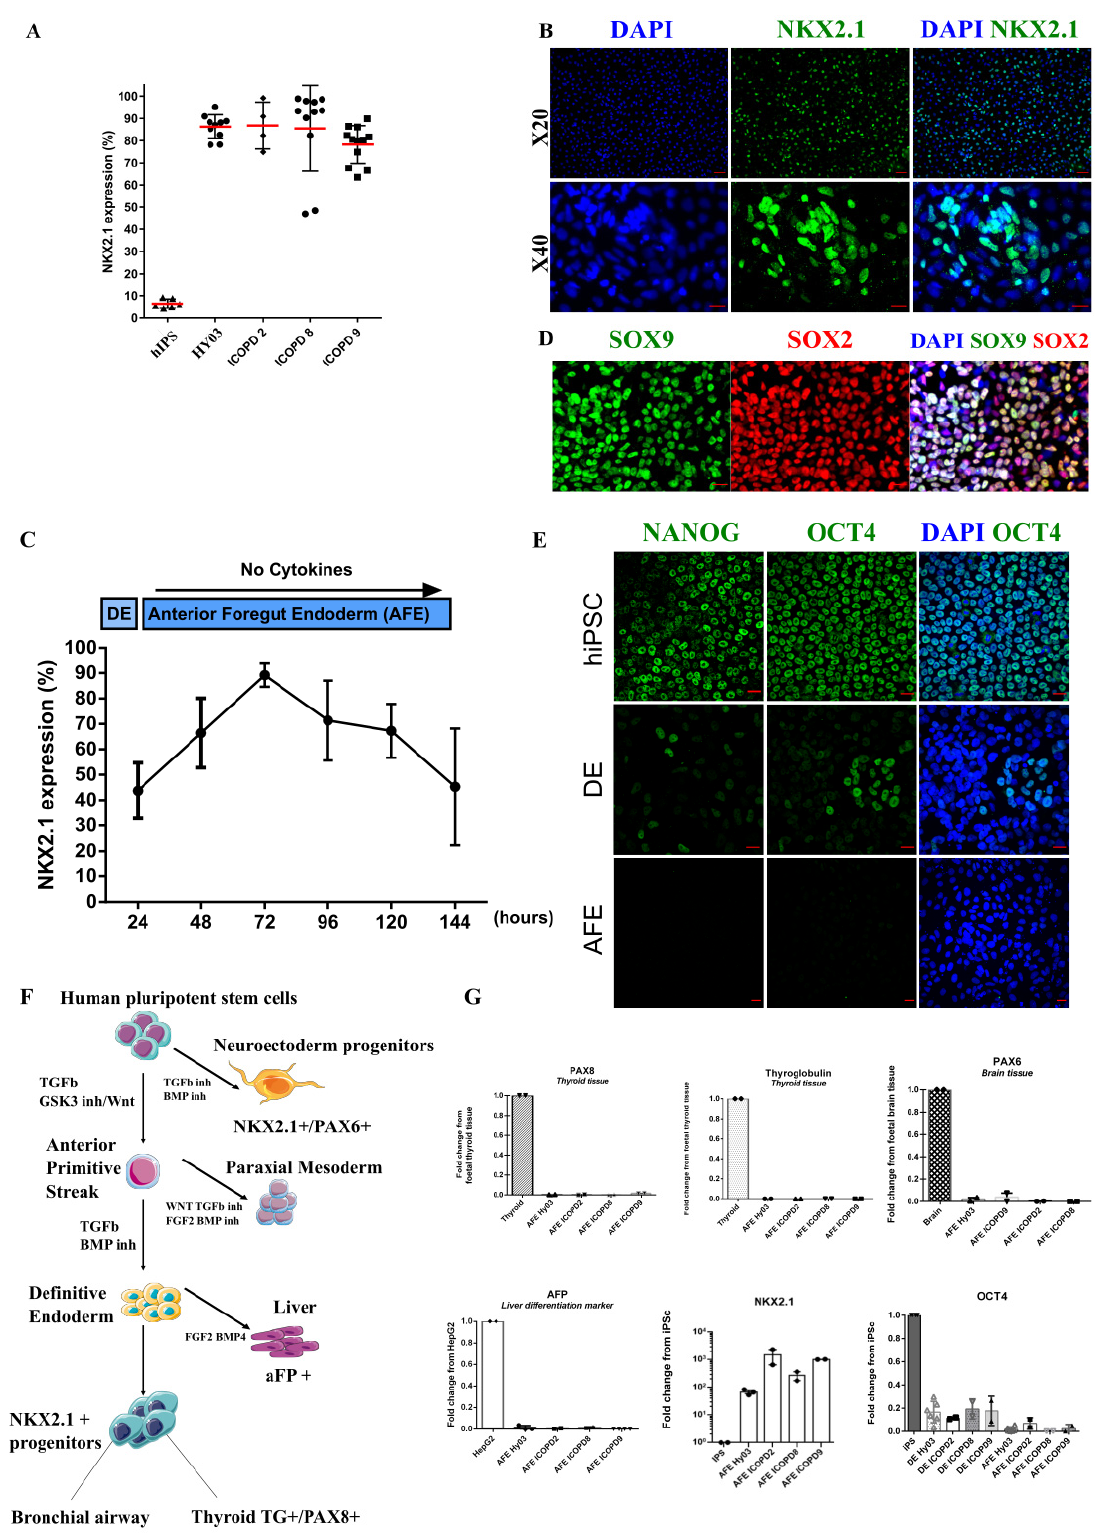
Figure 3. Anterior foregut endoderm characterization. ( A ) Percentage of NKX2.1+ cells after vAFE induction in the indicated cell lines. Undifferentiated hiPSCs: negative control. ( B ) Expression of NKX2.1, a ventral anterior foregut endoderm marker, assessed by immunofluorescence (HY03 cell line). Scale bar: 20 µ m. ( C ) NKX2.1 expression kinetics (n = 3, HY03 cell line). ( D ) Expression of